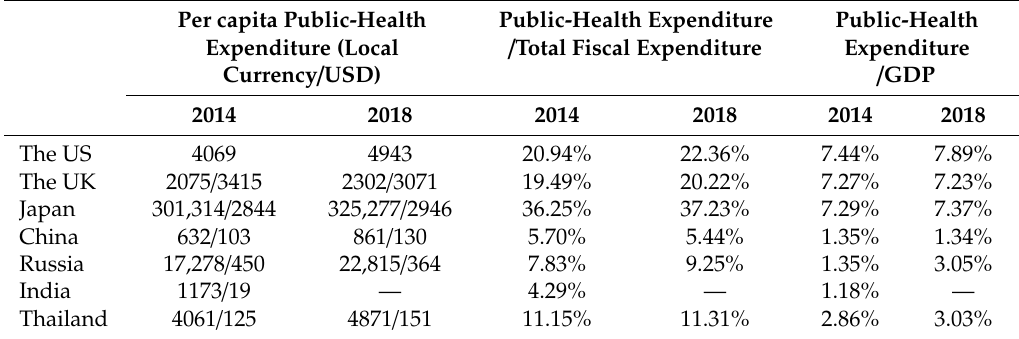
Table 3. The public-health expenditure of seven